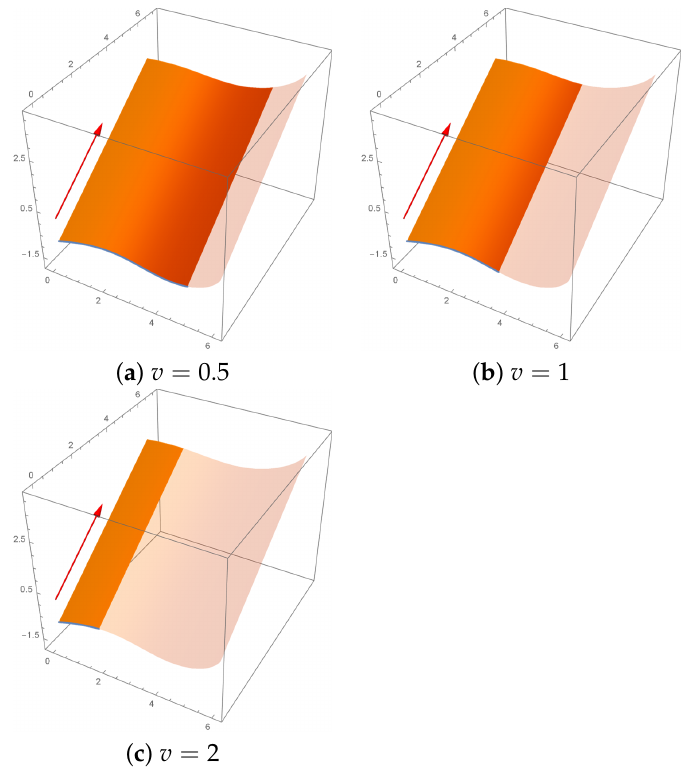
Figure 21. Extruded surface generated by cubic fractional Bézier curves with different fractional